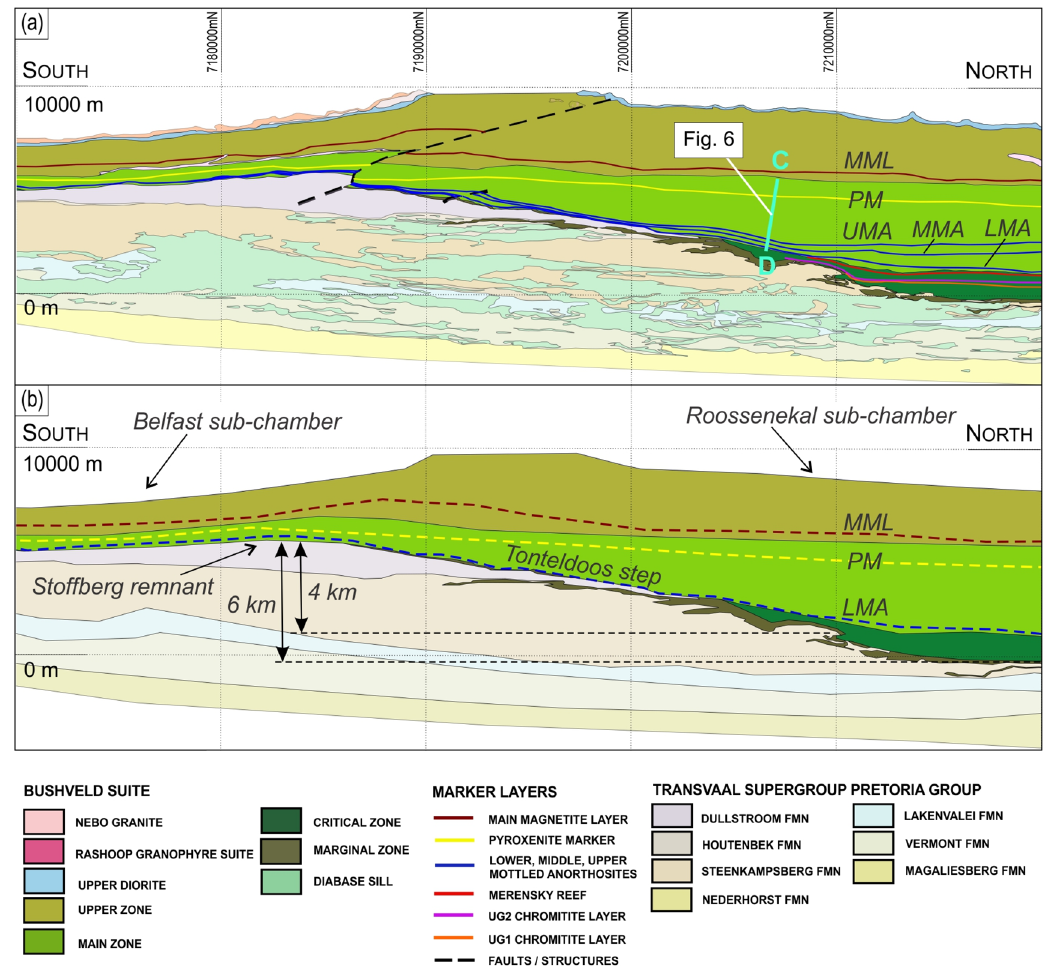
Figure 2. Geological along-strike section of the southeastern part of the Bushveld Complex in the Tonteldoos area. ( a ) The section is of the transect line AB in Fig. 1, looking at − 11° towards 270° azimuth. The section was constructed by rotating the 3D model to view the detailed geology of the complex and its immediate footwall in their true orientation. The section is not vertically or horizontally exaggerated and shows the true lithology morphology. ( b ) The schematic section prior to faulting highlights several important features of the complex: (1) the existence of the Roossenekal and Belfast sub-chambers with the intervening Stoffberg remnant of non- deformed host rocks, (2) the ~ 4-km and ~ 6-km thick vertical distance between the summit of the Stoffberg remnant with the Lower Mottled Anorthosite and the floor of the Roossenekal sub-chamber, respectively, (3) the concave geometry of the Pyroxenite Marker indicating that instantaneous top of the cumulate pile in the two sub-chambers was gently basinal with regards to the Stoffberg remnant. LMA, Lower Mottled Anorthosite; MMA, Middle Mottled Anorthosite; UMA, Upper Mottled Anorthosite; PM, Pyroxenite Marker; MML, Main Magnetite Layer. The CD line in ( a ) shows the location of the cross-section in Fig. 6. The figure was prepared by Richard Hornsey using Micromine 2021 Release